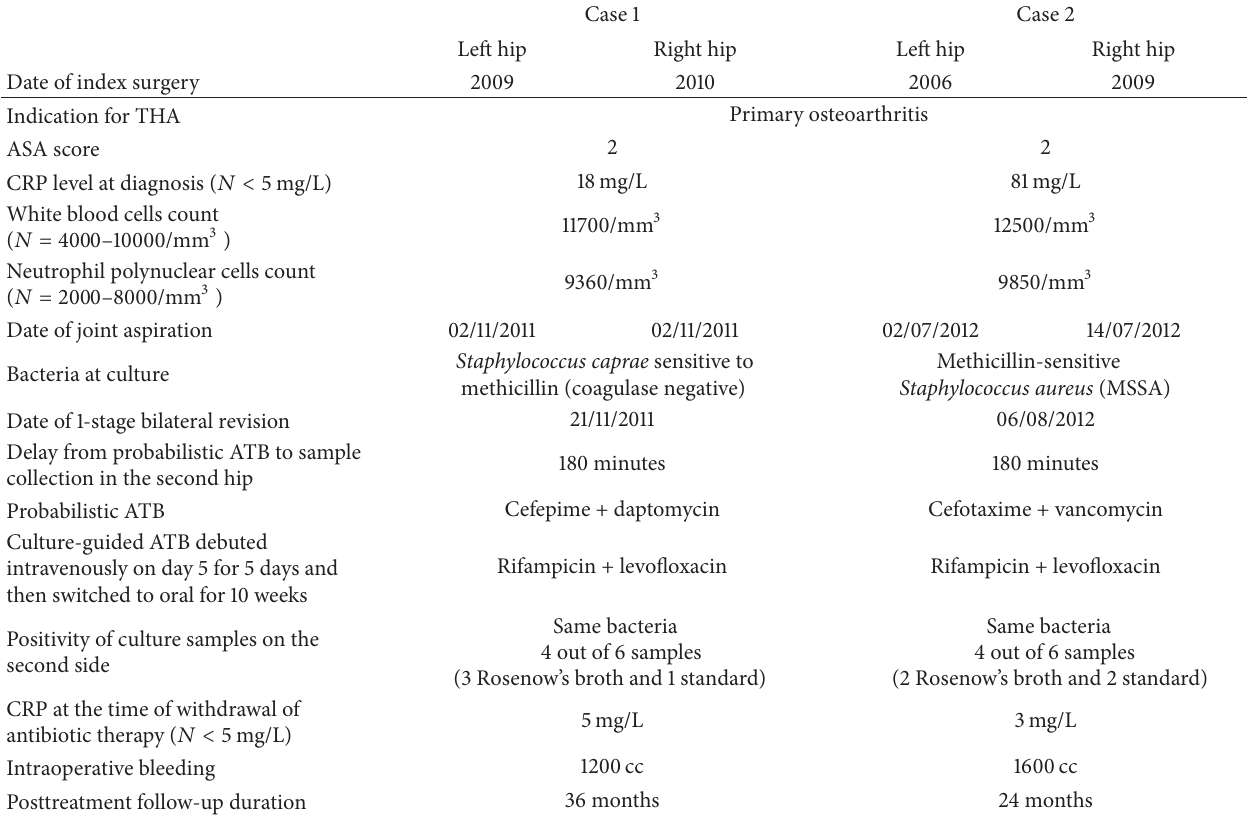
Table 1: Demographic, microbiological, and therapeutic